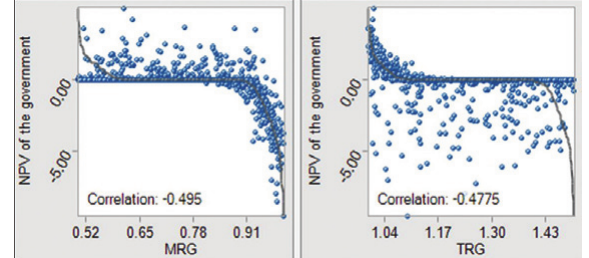
Fig. 3. The correlation scatter diagram (in million